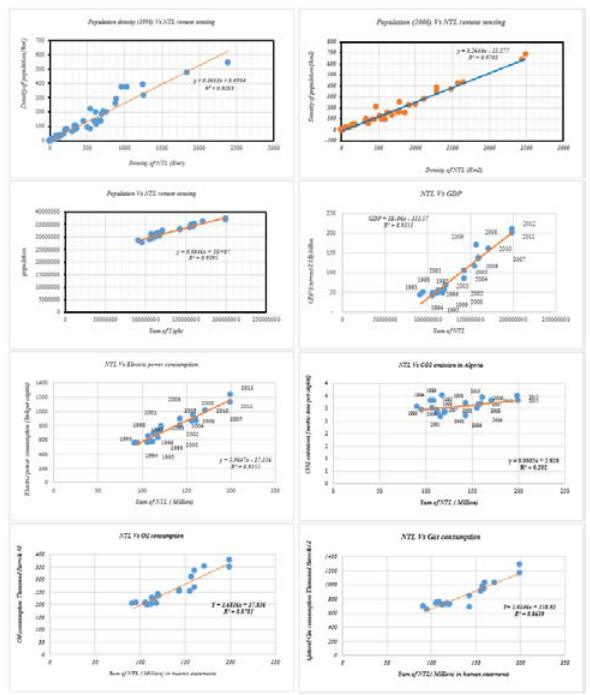
Figure 10. Relationship between NTL remote sensing and Socioeconomic Parameters in Algeria.